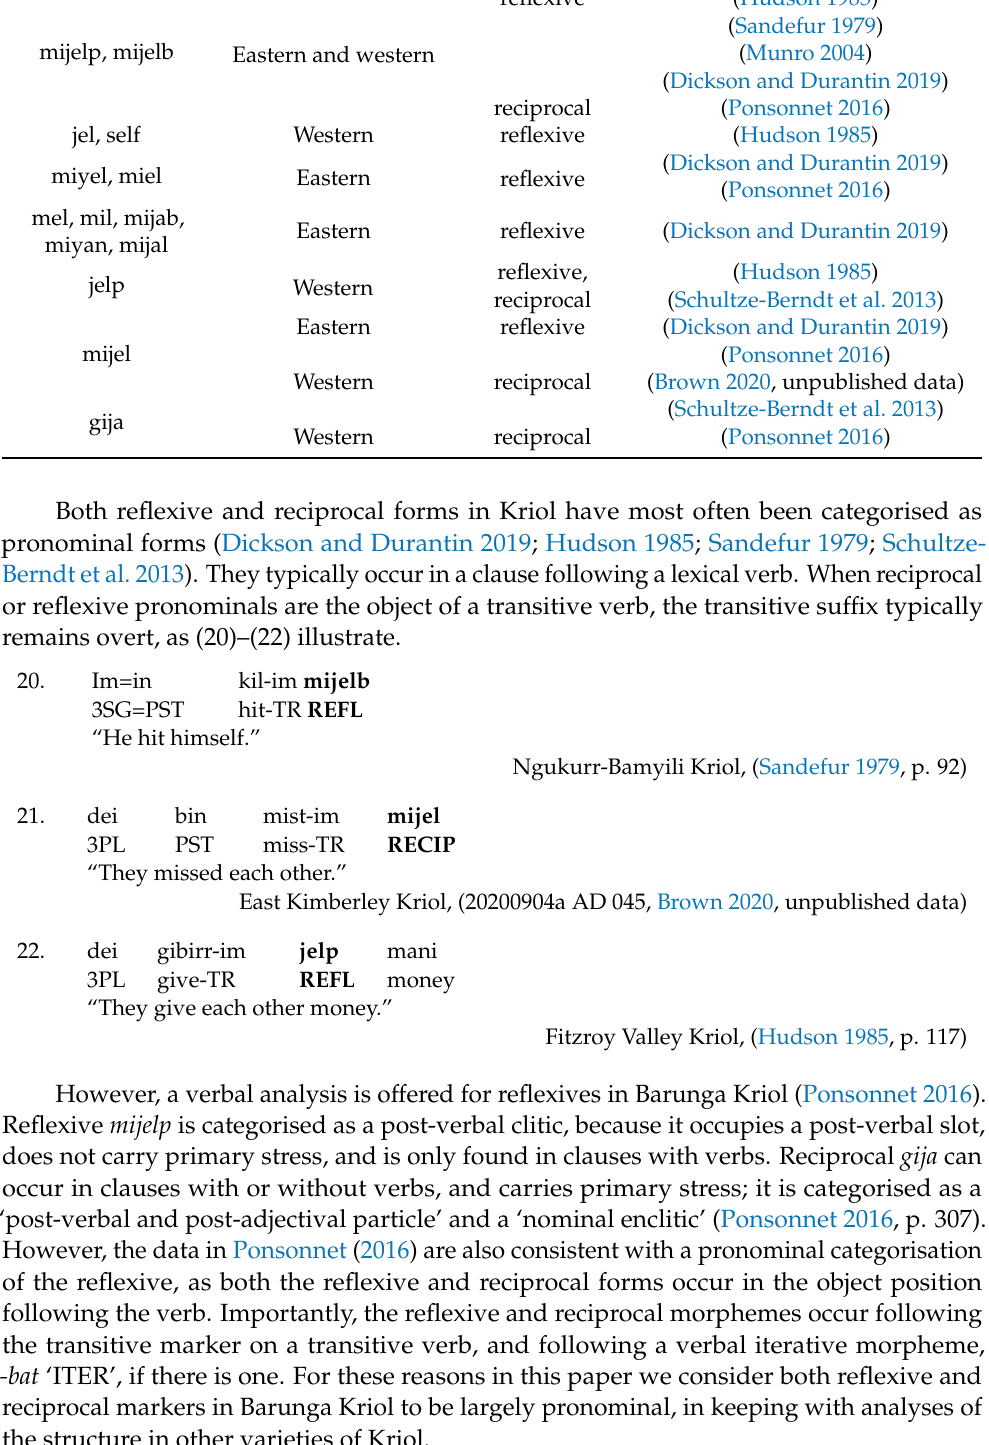
Table 2. Reflexive and reciprocal forms in documented varieties of Kriol.